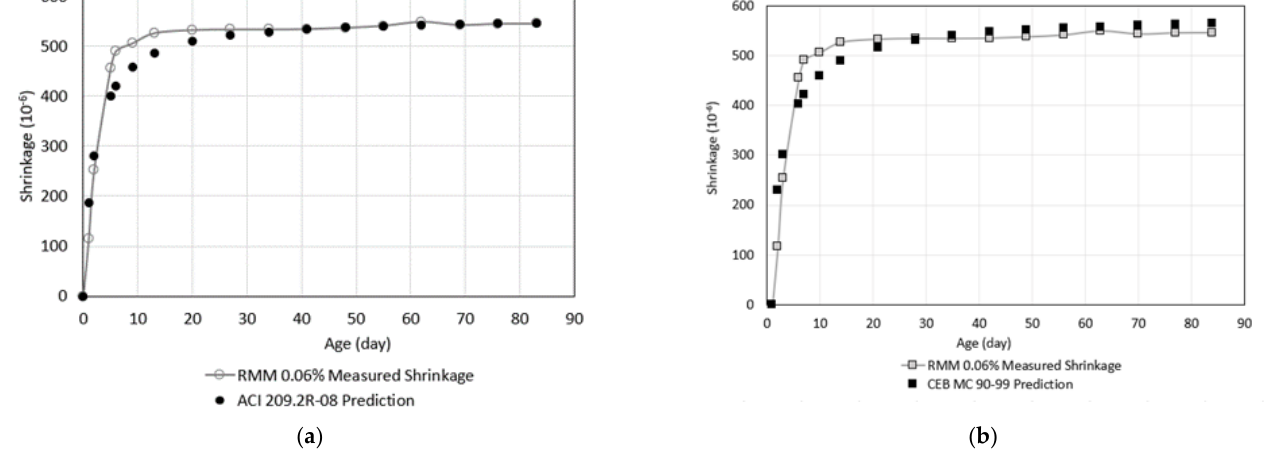
Figure 9. Comparison between the measured shrinkage and the predicted shrinkage by the modified ACI 209.2R-08 ( a ) and the modified CEB-MC 90-99 ( b ) models.